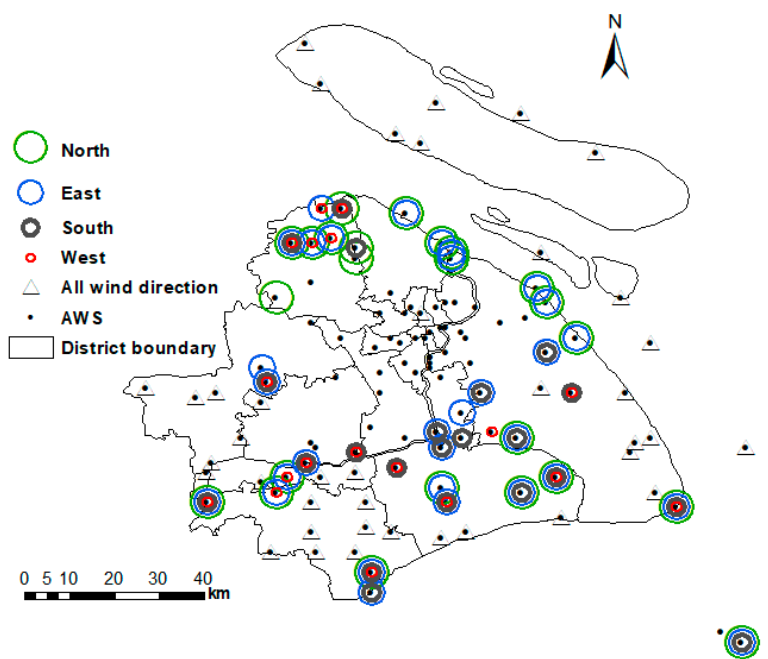
Figure 5. All 119 AWS locations in Shanghai ( ● ) and the wind directions the data were used to assess background wind based on criteria in Section 3.1: all directions (triangle), north (green), east (blue), south (grey), and west (red).